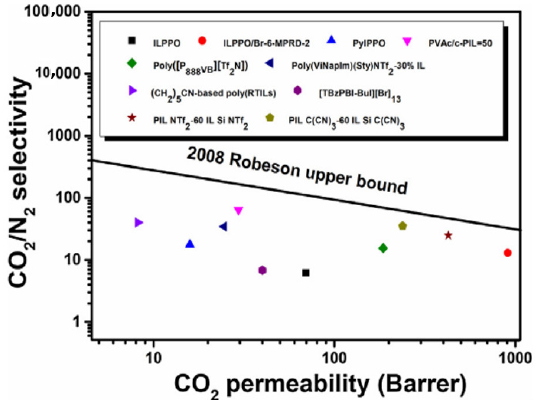
Figure 13. Reported literatures for FTMs vs. 2008 Robeson upper bound [126]. Table 5. Performance comparison of some recently reported FTMs.